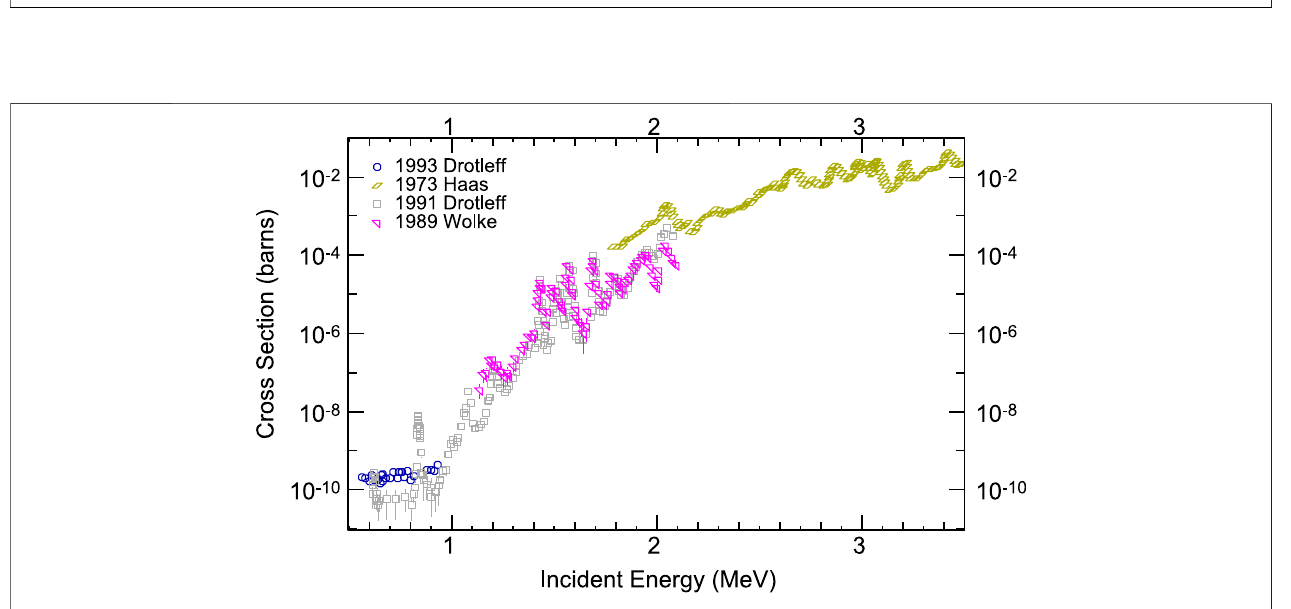
FIGURE 6 | A subset of the previous measurements of the 22 Ne( α ,n) 25 Mg reaction cross-section. Data retrieved from the EXFOR database version of October 8, 2020. Blue circles are upper limits.